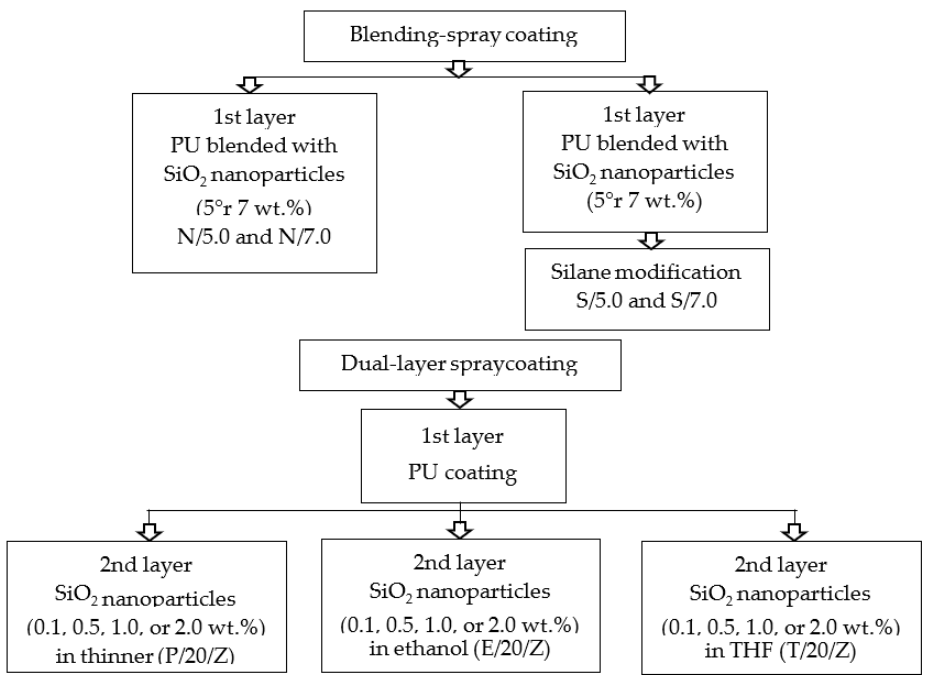
Figure 1. Summary of blending-spray coating and dual-layer spray coating methods.